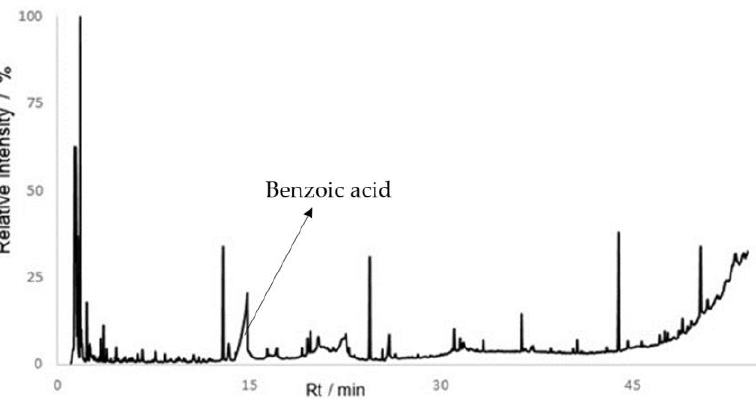
Figure 4. Chromatogram of composite fabric sample.